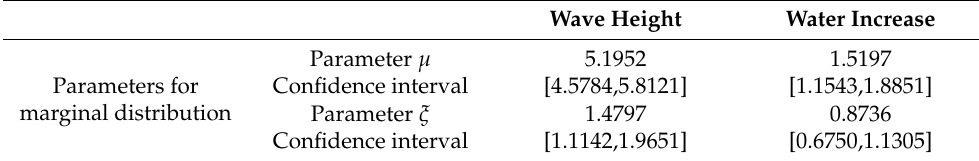
Wave Height Water Increase